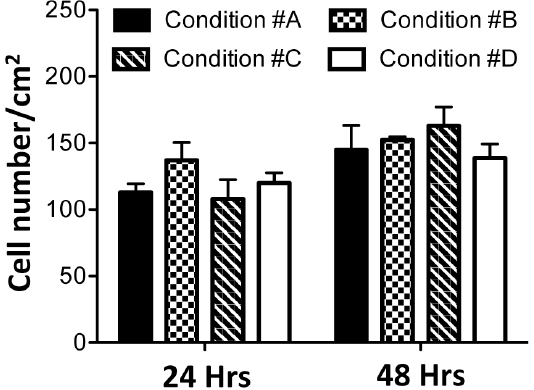
Figure 7. At 24 and 48 h after gel polymerization, viable cells were counted by ImageJ software. Experimental conditions are those illustrated in Figure 1. Values represent the mean of viable cell number/surface area (cm 2 ) ± SD.